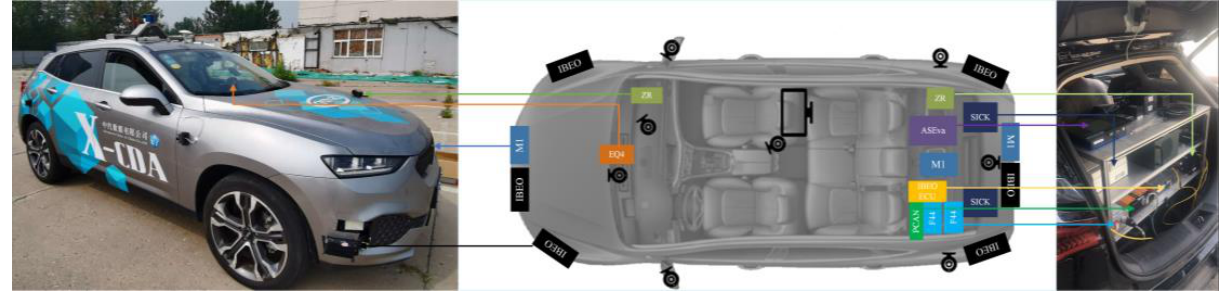
Figure 8. The platform and the layout of the scenario collection system in the platform. The NDD is obtained from the China Automotive Technology and Research Center Co., Ltd. (CATARC). The total mileage of the NDD is 114 thousand kilometers. The collection areas of the NDD cover representative cities in China, including Changchun, Beijing, Tianjin, Shanghai, Guangzhou, Haikou, Chongqing, and the surrounding areas of these cities. These regions have relatively developed economies, large populations, and traffic densities. Therefore, the scenario data collected are rich and diverse enough. The distribution of the collection areas of the NDD is shown in Figure 9.